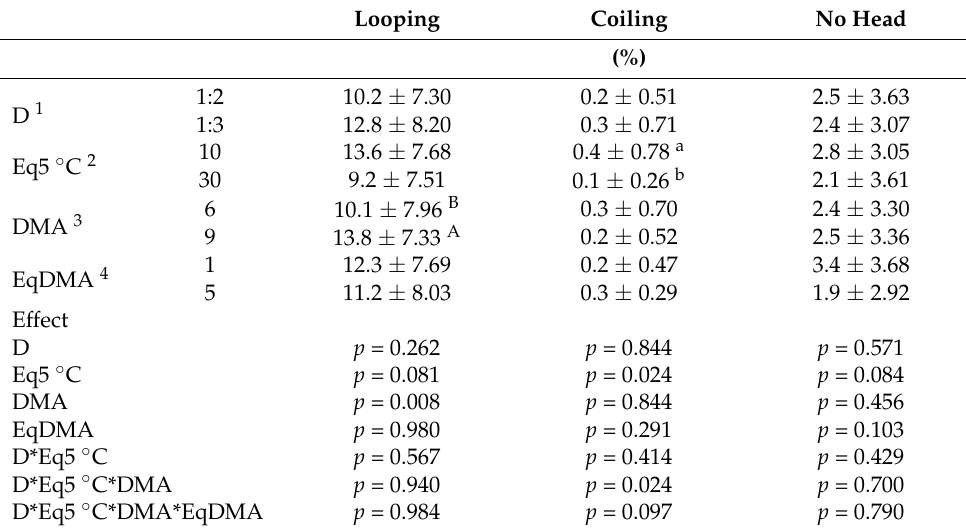
Table 4. Tail injuries in frozen common pheasant sperm while using two levels in each step (dilution, equilibration at 5 ◦ C, DMA concentration, equilibration time with DMA) of the process of freezing into pellets and the influence of the steps on the incidence of this damage (means ± SD). Looping Coiling No Head (%) D